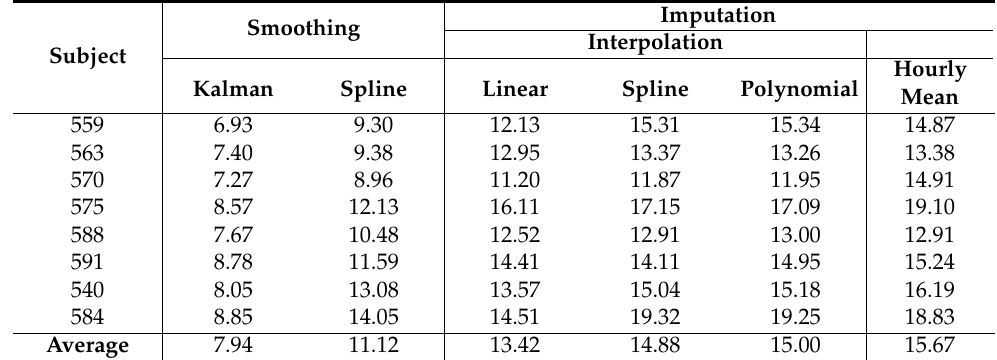
Table 6. Average RMSE for predicting glucose level using Transformer after